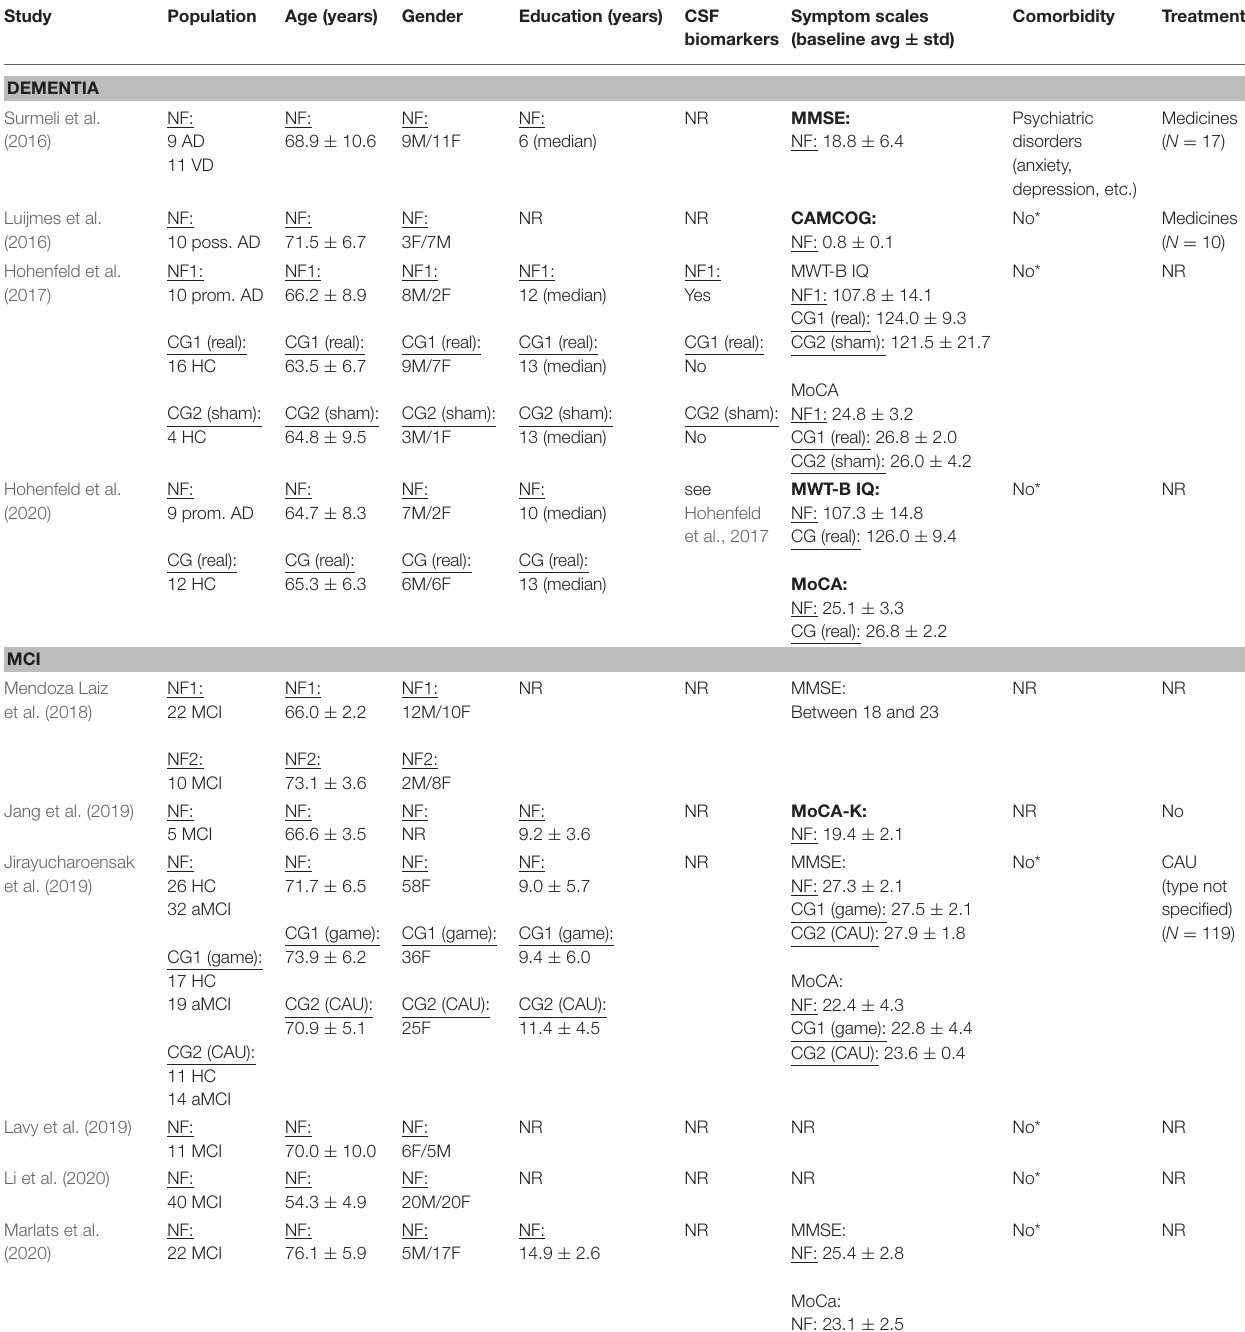
TABLE 2 | Summary of population characteristics. Study Population Treatment